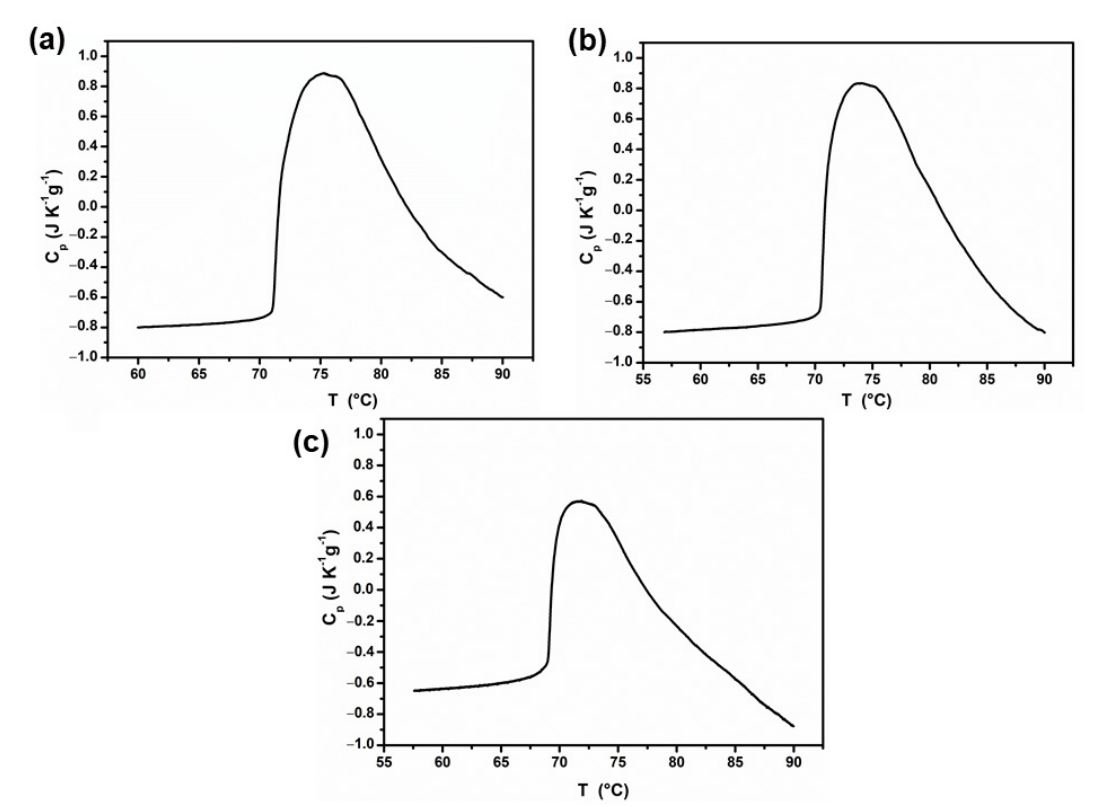
Figure 4. nano-Differential scanning calorimetry ( DSC) thermal profiles of pEFS8-26 aqueous solutions at concentra- Figure 4. Nano-Differential scanning calorimetry (DSC) thermal profiles of pEFS8-26 aqueous solutions at concentrations tions of ( a ) 0.5 g/L, ( b ) 1 g/L, and ( c ) 5 g/L. of ( a ) 0.5 g/L, ( b ) 1 g/L, and ( c ) 5 g/L.